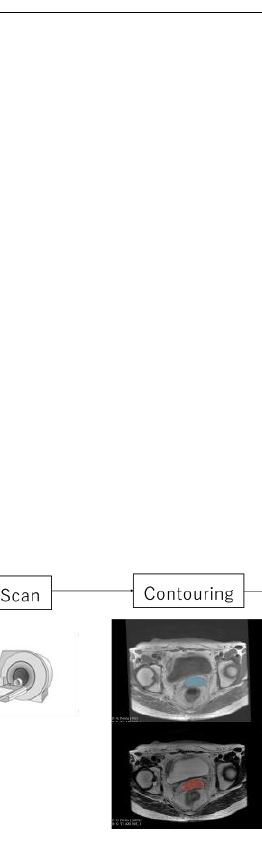
Figure 2. An example of the segmentation of CTV, extended-CTV (eCTV), and shrink-CTV (sCTV). Table 2. Feature type and associated